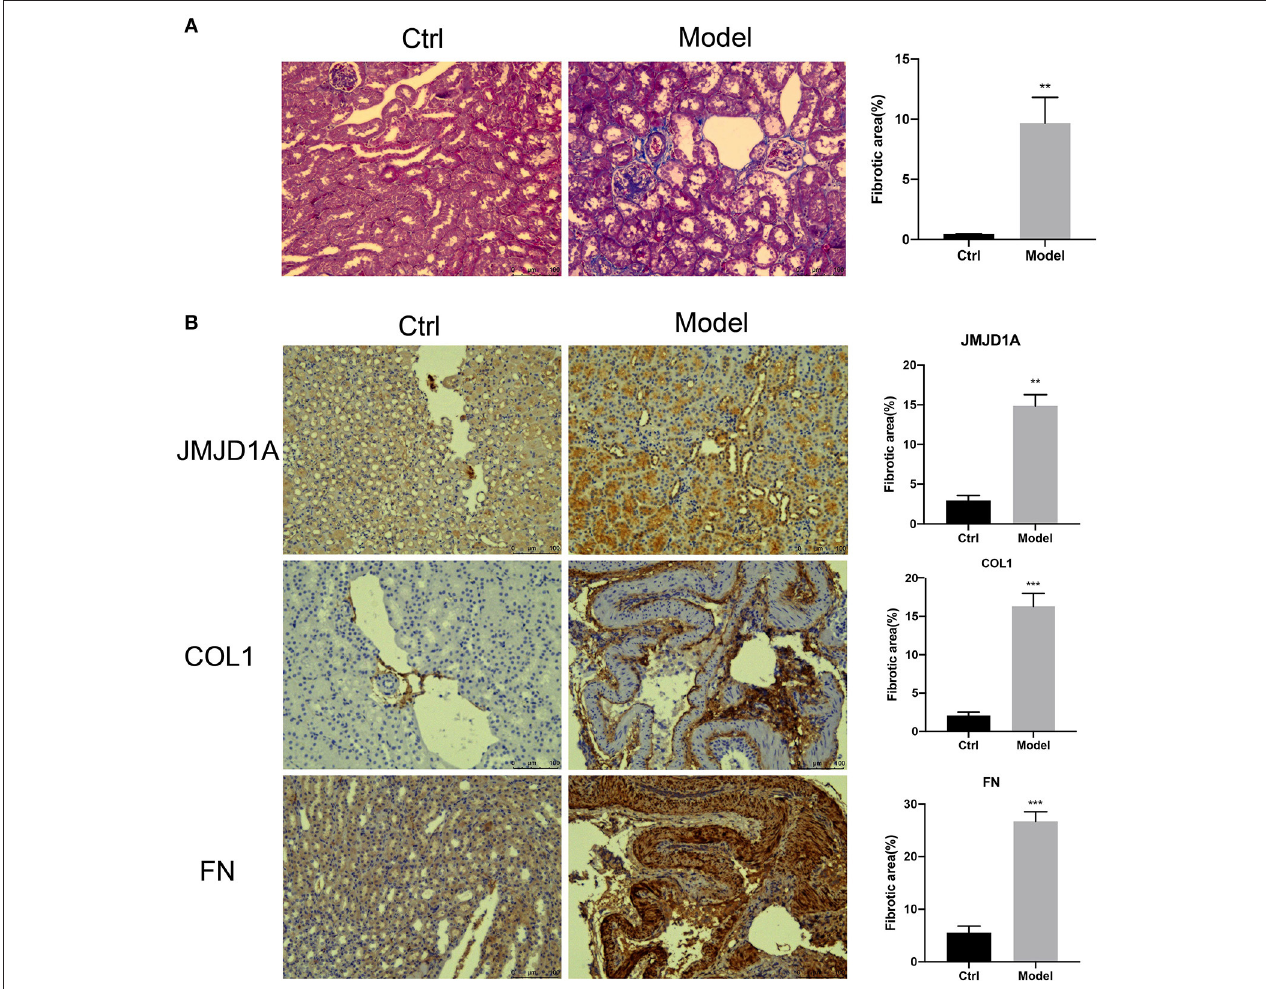
FIGURE 1 | (A) Representative images of unilateral nephrectomized mice with diabetic nephropathy combined with STZ vs. normal control mice showing glomerular collagen deposition (Masson trichrome staining) (scale bar, 100 µ m, × 200, n = 5, ** p < 0.001). (B) Quantification was performed using ImageJ analysis software. Kidney sections from both groups of mice were stained by IHC to detect the expression of JMJD1A, FN, COL1 (scale bar, 100 µ m, × 200, n = 5, ** p < 0.001, *** p <